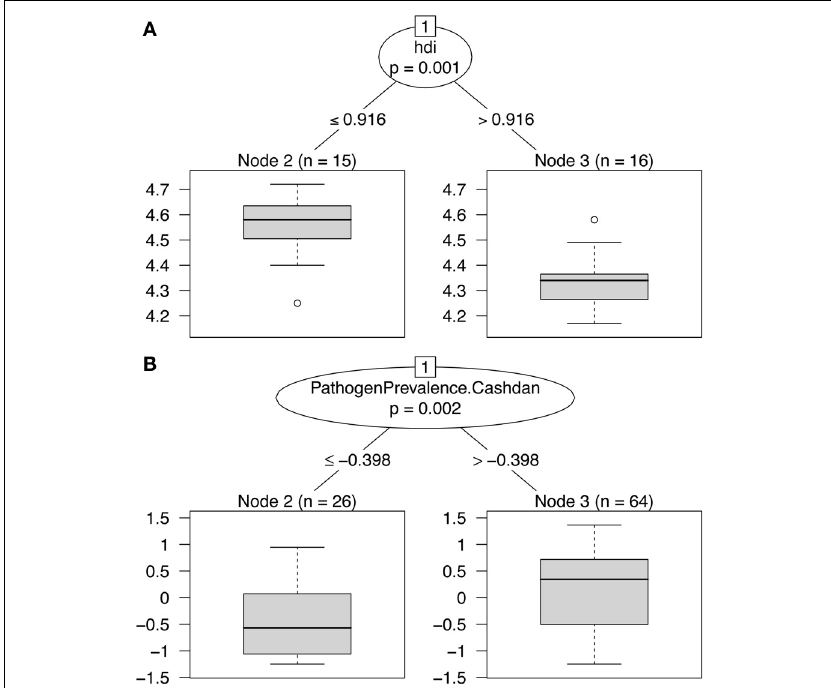
FIGURE 1 | Results of two conditional inference tree models for Murray et al. (2013)’s data on authoritarianism. A higher score indicates more authoritarianism. ( A = Sample 1: 31 Countries, B = Sample 2: 90 cultures from the Standard Cross-Cultural